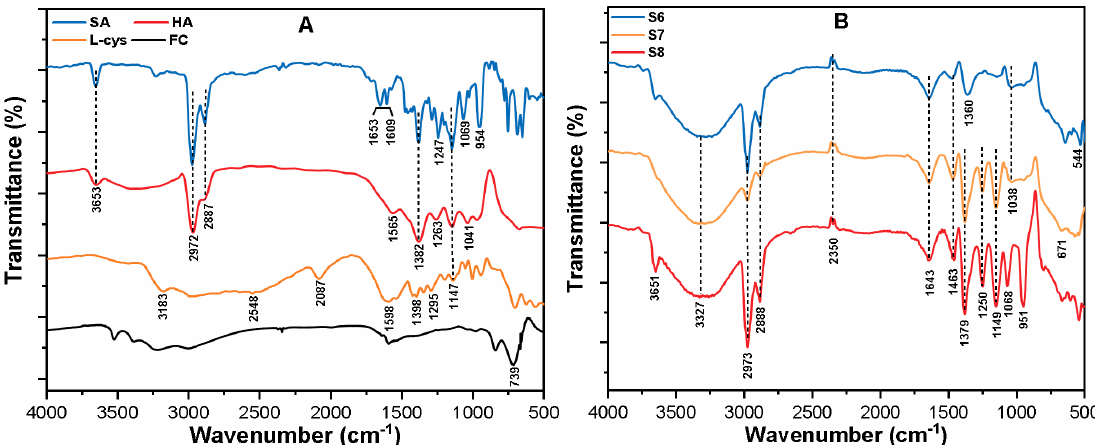
Figure 8. FT-IR spectra of ( A ) pristine organic ligands (HA, SA, L-cys, and FC); ( B ) synthetic water (S6, S7, and S8) flocs in obtained at OD in coagulation process.